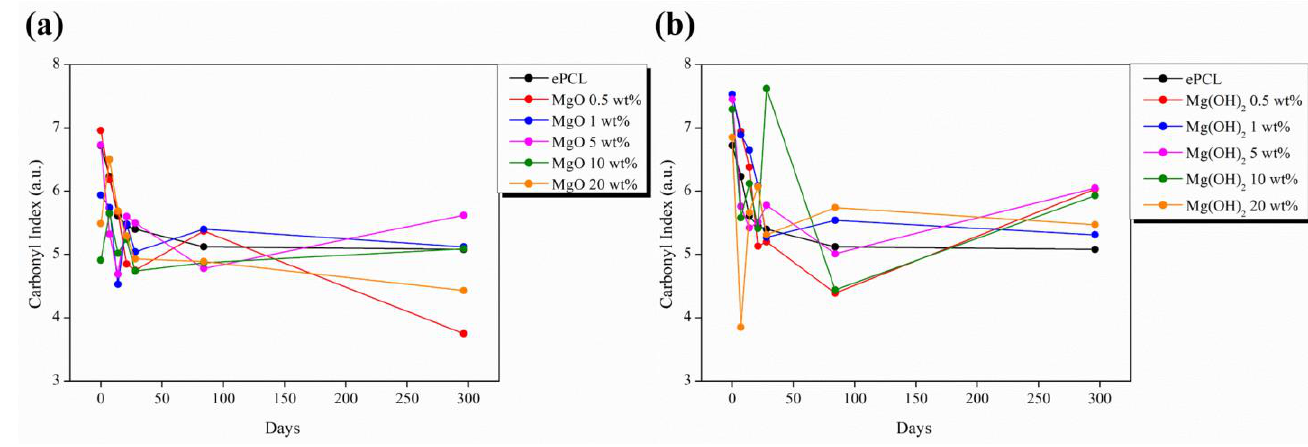
Figure 8. CI % with time changing of ( a ) ePCL + MgO and ( b ) ePCL + Mg(OH) 2 .